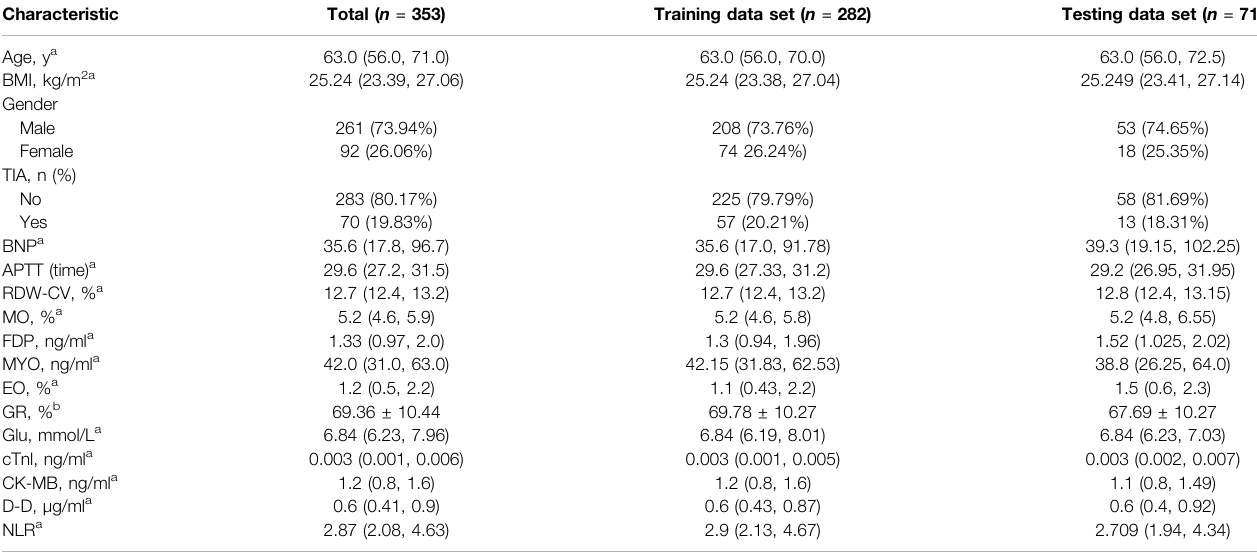
TABLE 2 | Patient characteristics divided by training data set and testing data set.